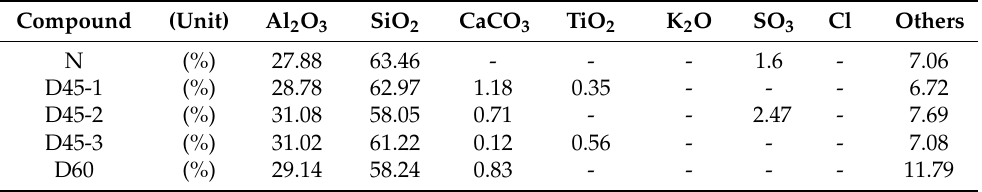
Figure 11. XRD results and peaks for both untreated soil (N) and the treated distance of 450 mm (D45). Table 8. Chemical composition of untreated soil (N) and treated distances of 450 mm (D45) and 600 mm (D60) after